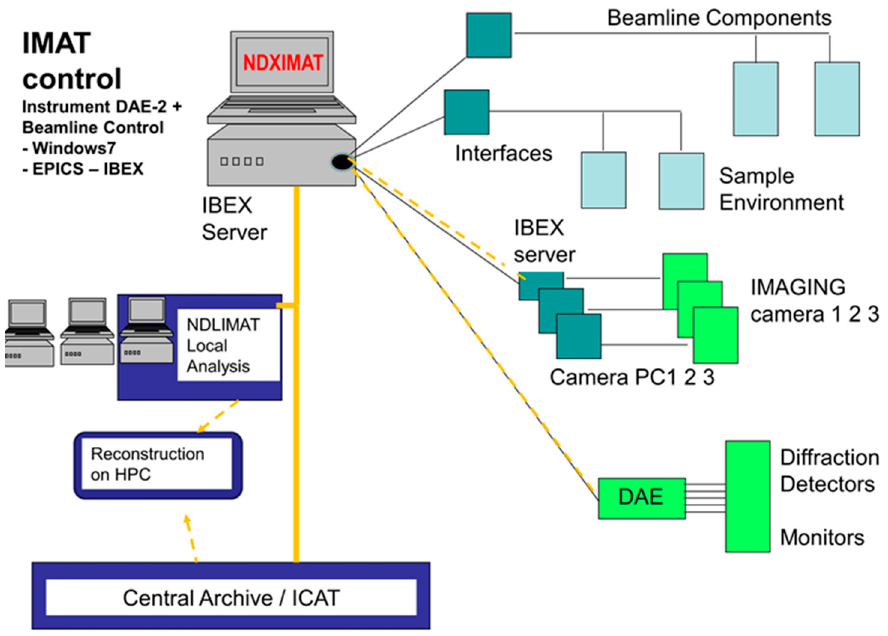
Figure 6. IMAT data management structure.